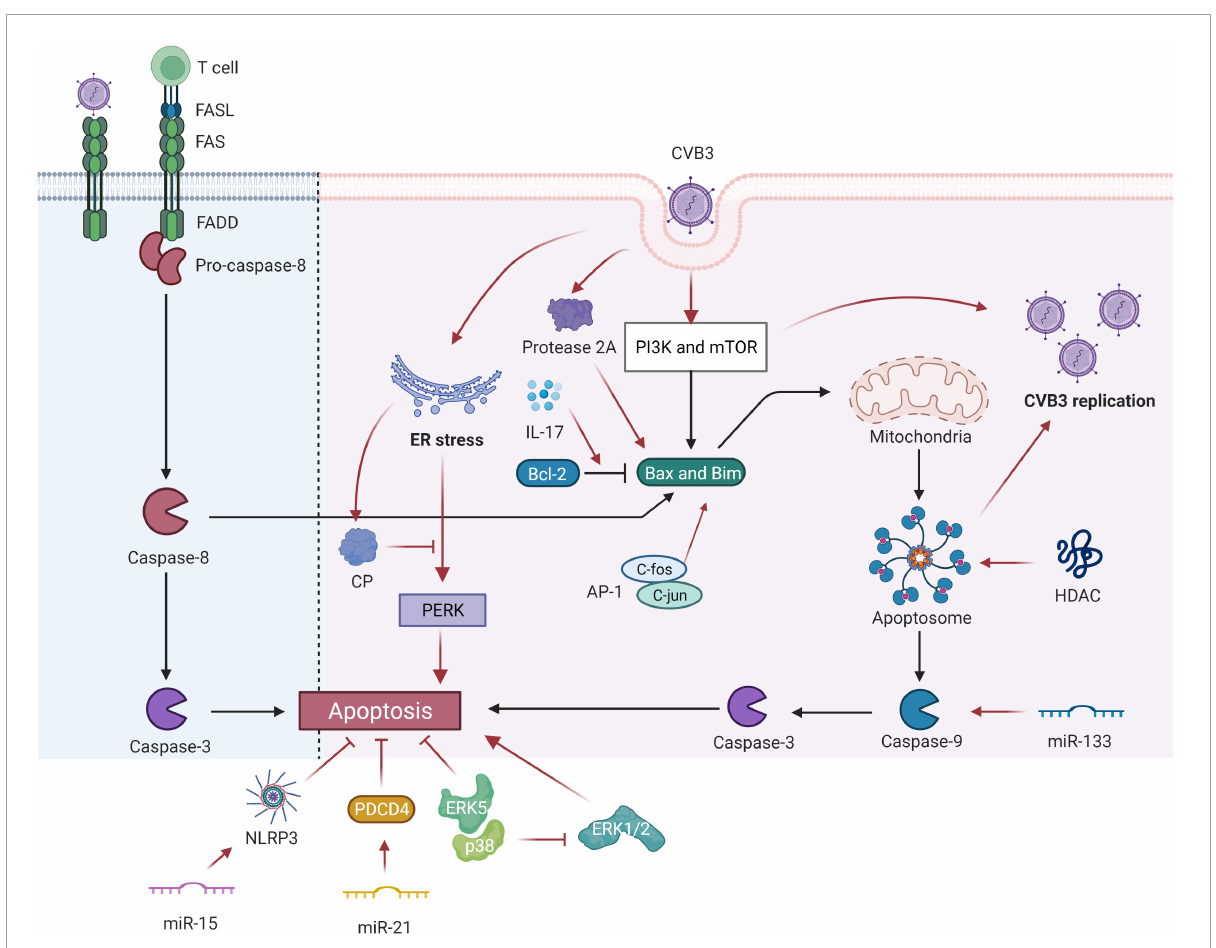
FIGURE1 Coxsackievirus B3 (CVB3) manipulates cell apoptosis. CVB3 infection can markedly induce myocardial apoptosis via death receptor–mediated and mitochondrial-mediated signaling pathways. Viral infection induces abnormal expression of Fas antigen in the myocardium and cross-links with FasL of active cells. Activated CTL binds to target cells via Fas/FasL and causes apoptosis. The PI3K and mTOR-signaling pathways participate in the CVB3-induced VMC by mediating the proapoptosis factor Bim, Bax, caspase-9, caspase-3, and viral replication. The inhibition of HDAC activity increases CVB3 replication by enhancing autophagosome formation and ensuing increased myocardial apoptosis. IL-17A mediated cardiomyocyte apoptosis by regulating the Bax/Bcl-2 ratio. miR-133 targets caspase-9 and promotes cardiac cell apoptosis. miR-15 could suppress cell viability and promote CVB3-induced cell apoptosis by modulating the NLRX1-mediated NLRP3 inflammasome. miR-21 alleviates CVB3-induced myocarditis by protecting myocardial apoptosis and repressing PDCD4 expression. CVB3-stimulated cytotoxicity can be inhibited by kinase ERK5, coupled with p38 kinase activity. However, p38 promotes apoptosis through ERK1/2 inhibition indirectly. c-Fos can compose AP-1 with c-jun gene products that regulate the transcription of apoptosis-related genes. Picornavirus protease 2A in CVB3 induced apoptosis through multiple converging pathways. ER-initiated apoptosis was induced by CVB3-infected cardiomyocytes and caused myocardial apoptosis through ER stress by the PERK pathway. CP, which is located within the endoplasmic reticulum Ca2+ binding proteins, can relieve ERS-initiated apoptosis in VCM. CVB3, coxsackievirus B3; CTL, cytotoxic T lymphocytes; ER, endoplasmic reticulum; Bcl-2, B-cell lymphoma 2; Bax, Bcl-2-associated X protein; HDAC, histone deacetylase; NLRP3, NLR family pyrin domain containing 3; PDCD4, programmed cell death 4; ER, endoplasmic reticulum; CP, calumenin